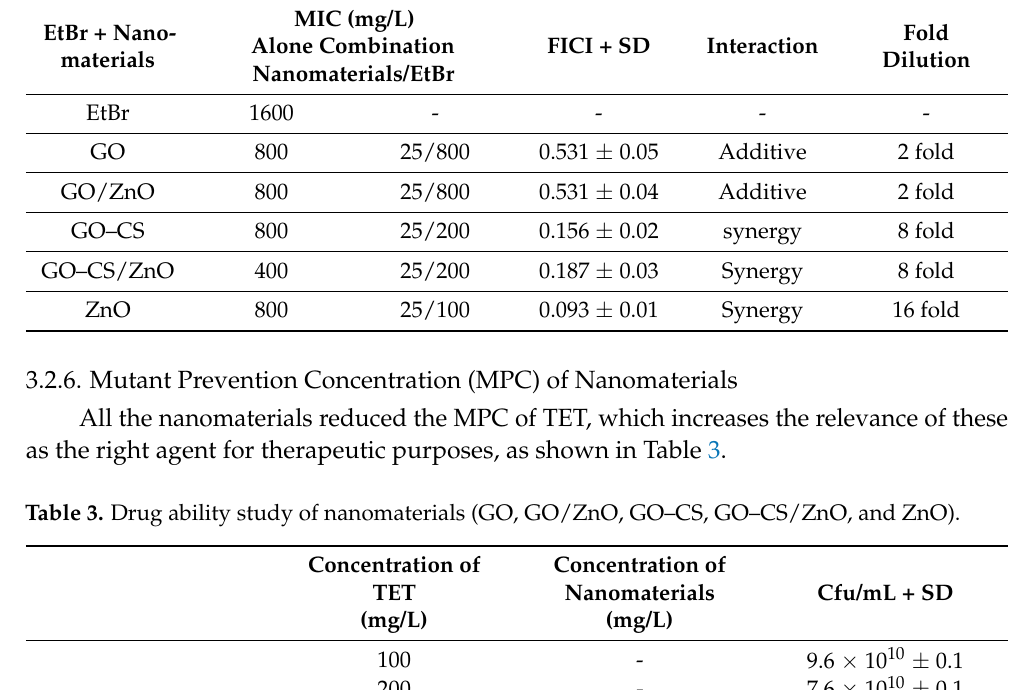
Concentration of Concentration TET (mg/L)